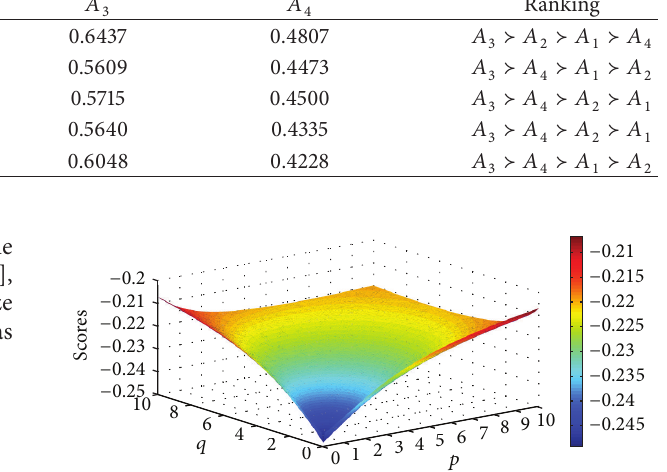
Figure 9: Scores for District 𝐴 1 obtained by the IIFWBM operator (𝑝 ∈ (0, 10],𝑞 ∈ (0, 10]) .